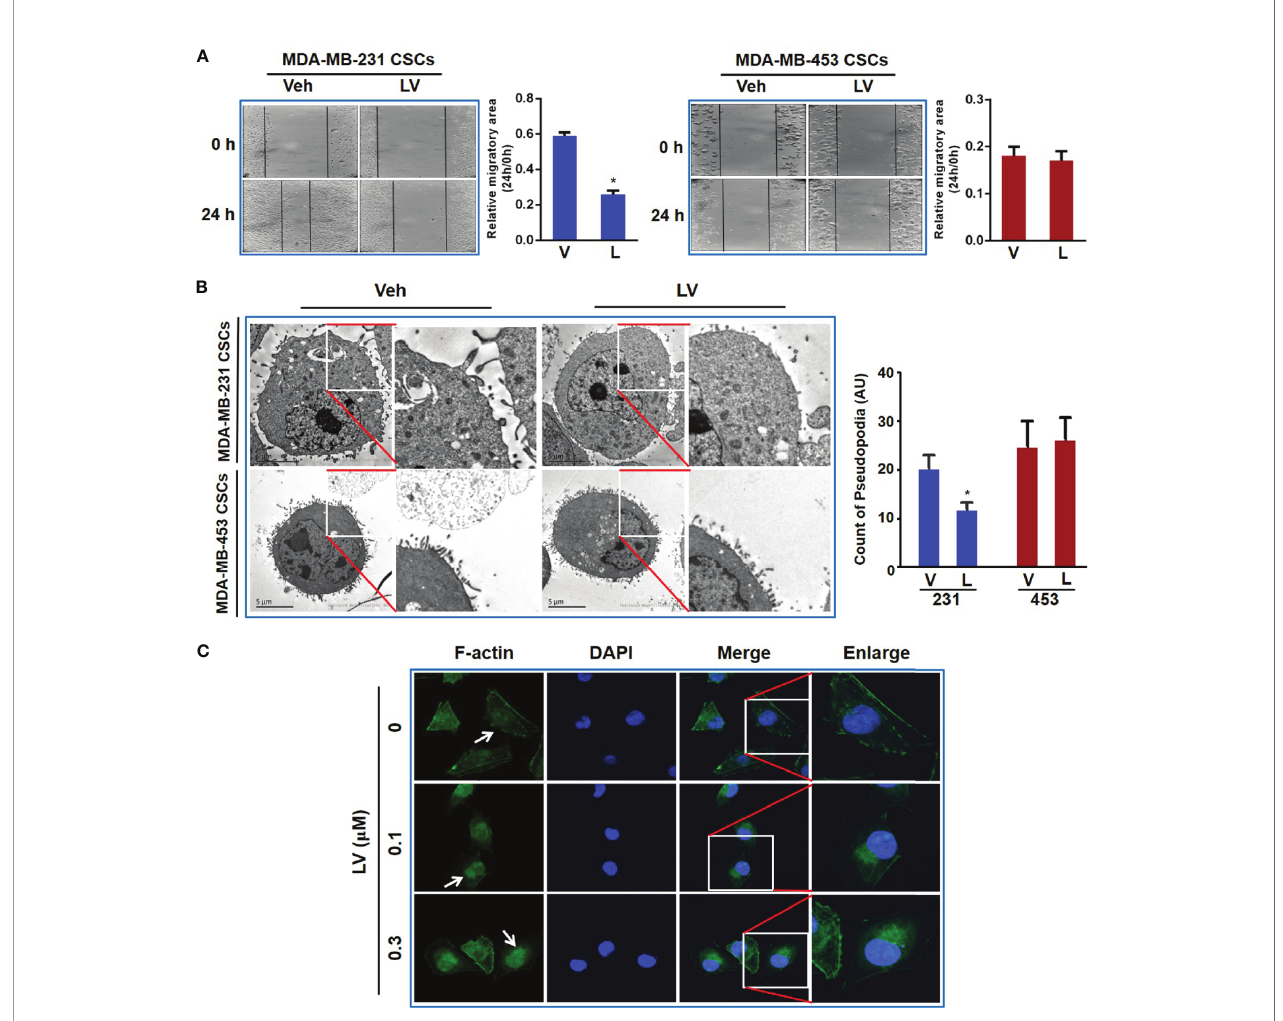
FIGURE 5 | Lovastatin inhibits migration of TNBC CSCs in vitro . Representative cell images of wound-healing assay in MDA-MB-231 and MDA-MB-453 CSCs treated with vehicle or lovastatin (1 m M, 24 h). Right, quanti fi cation of relative migratory area (A) . Representative TEM micrographs showing the pseudopodia in MDA- MB-231 and MDA-MB-453 CSCs after treatment with lovastatin (1 m M, 48 h). Scale bar = 5 m m (B) . Representative confocal images of immuno fl uorescence staining for F-actin in MDA-MB-231 after treatment with vehicle or lovastatin (0.1 or 0.3 m M, 48 h). Blue, DAPI staining of the nucleus. Original magni fi cation: 63× (C) . * P < 0.05, compared with control; V or Veh, vehicle; L or LV, lovastatin; AU, arbitrary